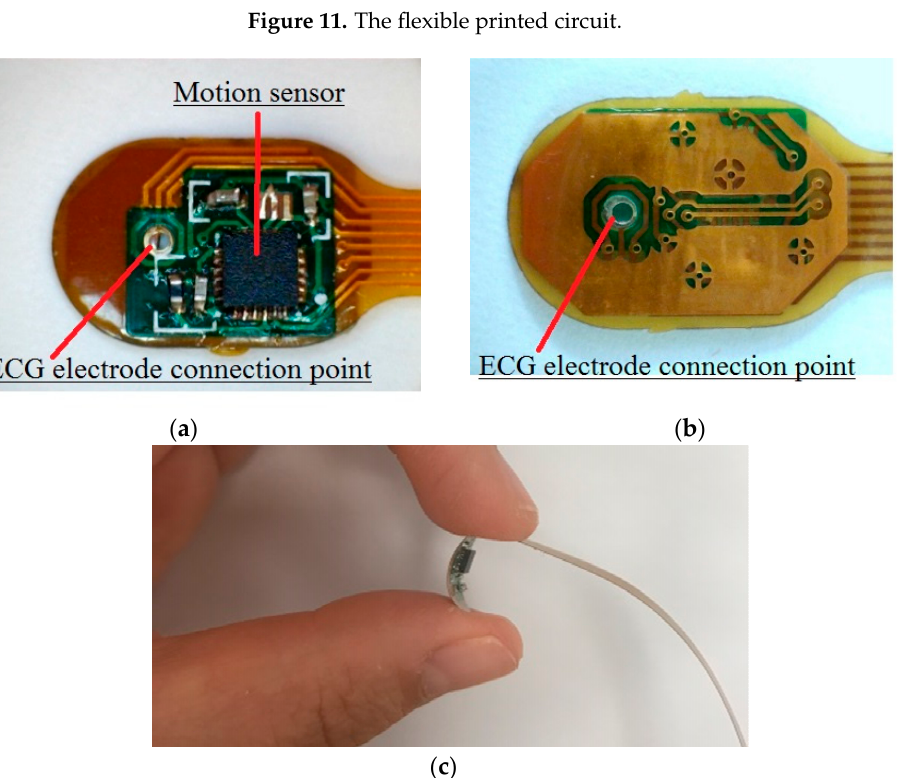
Figure 12. The motion sensor mini flexible printed circuit board (FPCB): ( a ) Top view; ( b ) rear view; ( c ) the flexibility of the FPCB.